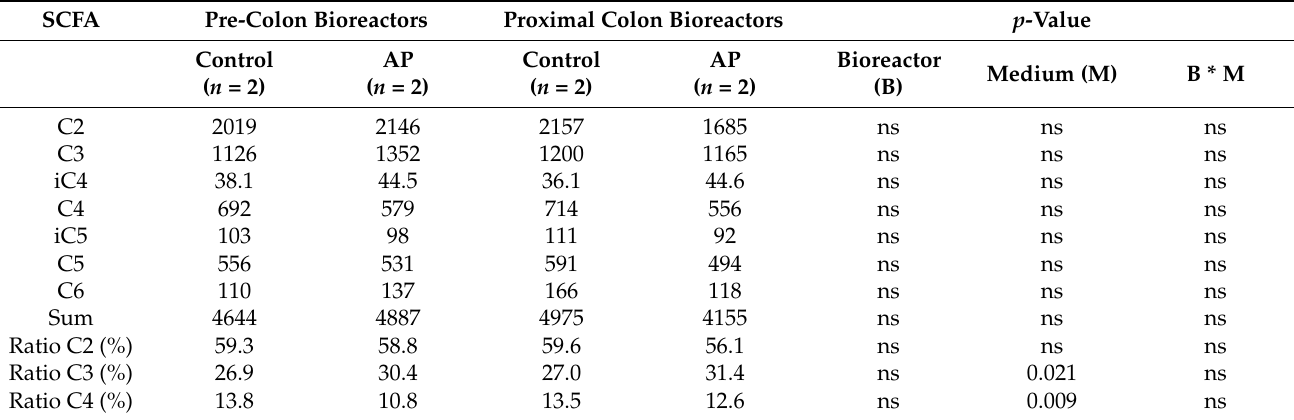
Table 2. SCFA results (mg/L) and molar ratio C2, C3 and C4 for pre-colon and proximal colon effluents of baby-SPIME (control vs.